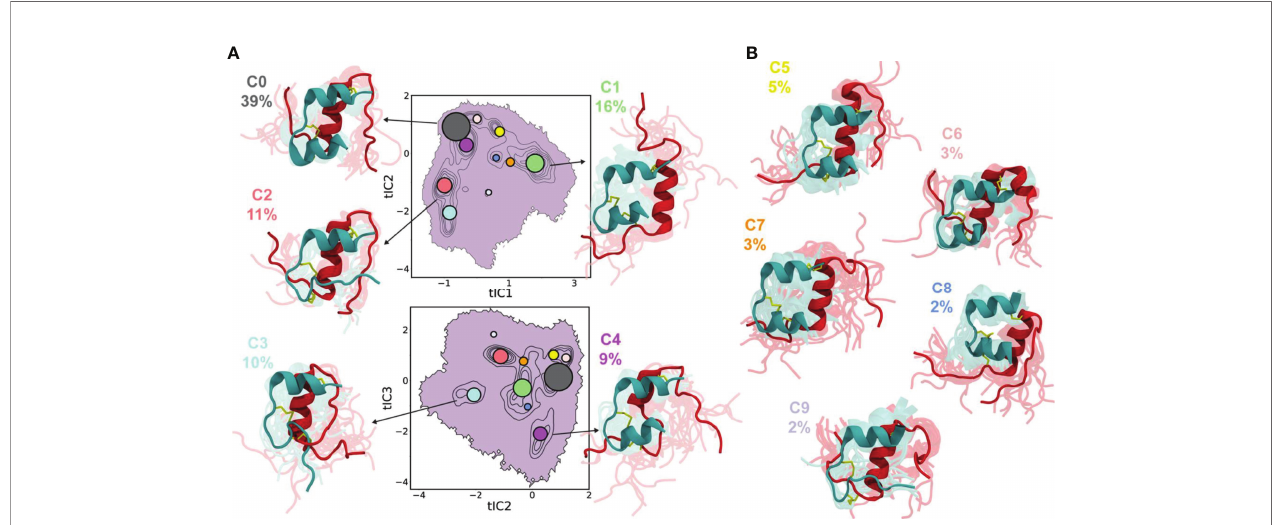
FIGURE 7 | Conformational ensembles of the insulin monomer. Projections of ten conformers of the insulin monomer onto tIC1 vs tIC2 (top) and tIC2 vs tIC3 (bottom), with clusters indicated by contours. Each circle represents the median tIC values for a cluster, and the radius of circle is proportional to the physical weight of the cluster. Representative conformers for (A) fi rst fi ve clusters (C0 – C4) constitute ~85% of the population and (B) the remaining clusters (C5 – C9) constitute 15% of the population. The A-chain and B-chain of insulin are represented by teal and red cartoon representations, respectively. The abbreviation ‘ tIC ’ means time-lagged independent component. Reprinted from Busto-Moner et al. (132), an article published by American Chemical Society under the terms of the Creative Commons Attribution License